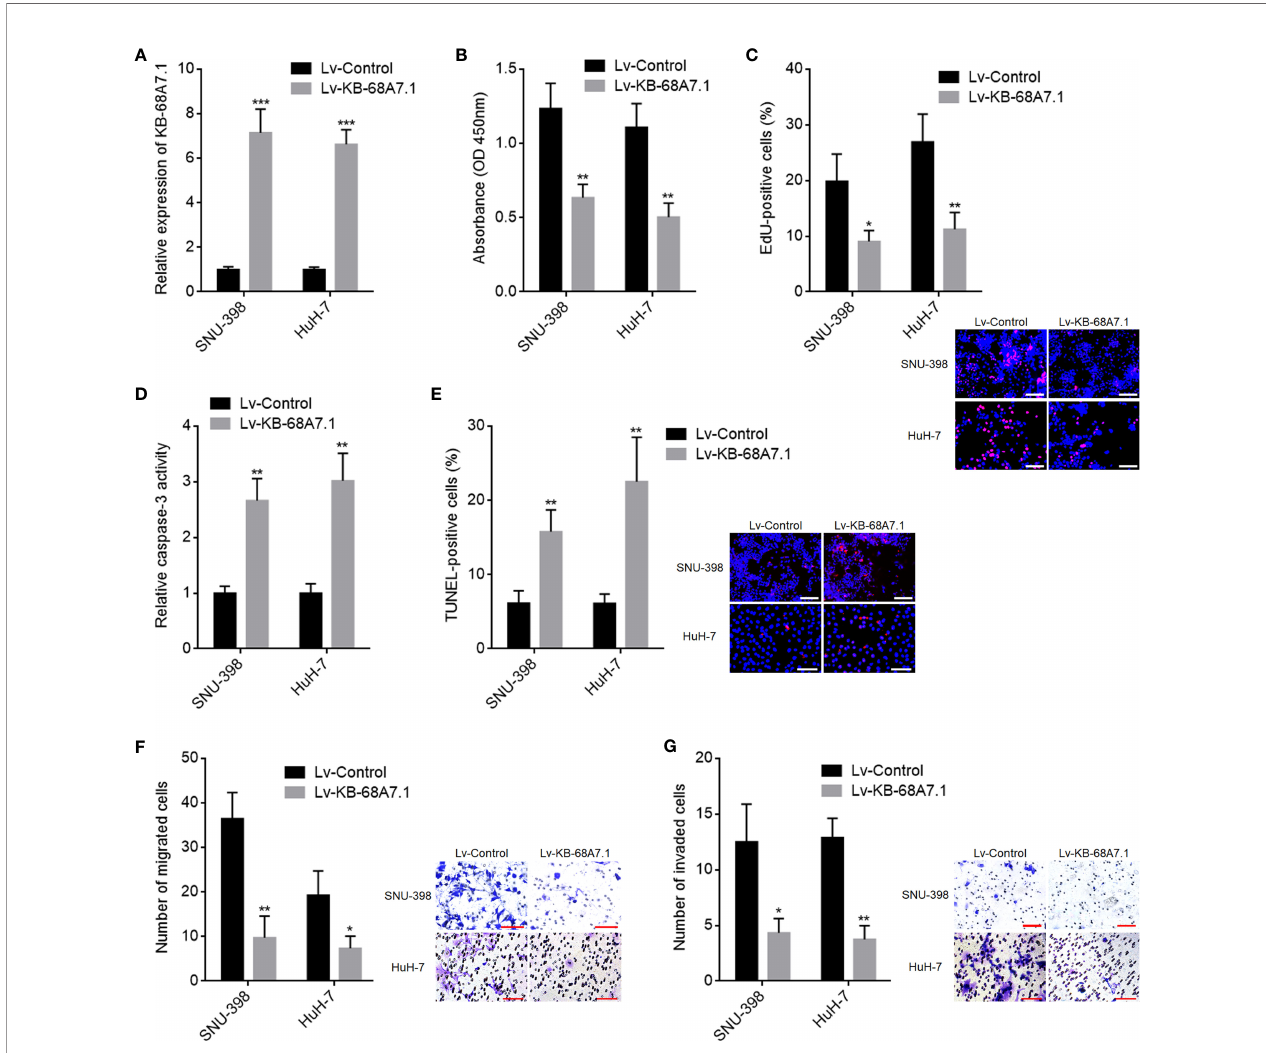
FIGURE 2 | The roles of KB-68A7.1 overexpression in HCC cellular proliferation, apoptosis, migration, and invasion. (A) KB-68A7.1 expression in SNU-398 and HuH-7 cells with KB-68A7.1 stable overexpression or control was measured by RT-qPCR. (B) Cellular proliferation of SNU-398 and HuH-7 cells with KB-68A7.1 overexpression or control was measured by CCK-8 assay. (C) Cellular proliferation of SNU-398 and HuH-7 cells with KB-68A7.1 overexpression or control was measured by EdU incorporation assay. Representative images are shown on low right. Red colour indicates EdU-positive and proliferative cells. Scale bars = 100 µm. (D) Cellular apoptosis of SNU-398 and HuH-7 cells with KB-68A7.1 overexpression or control was measured by caspase-3 activity assay. (E) Cellular apoptosis of SNU-398 and HuH-7 cells with KB-68A7.1 overexpression or control was measured by TUNEL assay. Representative images are shown on the right. Red colour indicates TUNEL-positive and apoptotic cells. Scale bars = 100 µm. (F) Cellular migration of SNU-398 and HuH-7 cells with KB-68A7.1 overexpression or control was measured by Transwell migration assay. Representative images are shown on the right. Scale bars = 100 µm. (G) Cell invasion of SNU-398 and HuH-7 cells with KB-68A7.1 overexpression or control was measured by Transwell invasion assay. Representative images are shown on the right. Scale bars = 100 µm. Results are shown as mean ± SD based on three independent experiments. *p < 0.05, **p < 0.01, ***p < 0.001 by two-tailed unpaired